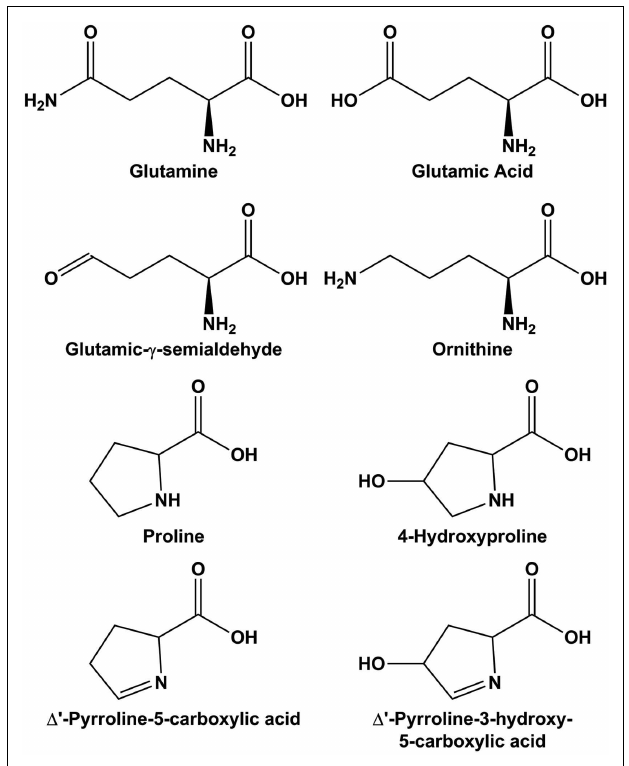
FIGURE 2 | Structure of molecules in the glutamine-arginine-proline pathway. Glutamic- γ -semialdehyde is the open-chain tautomer of ∆ 1 -pyrroline-5-carboxylic